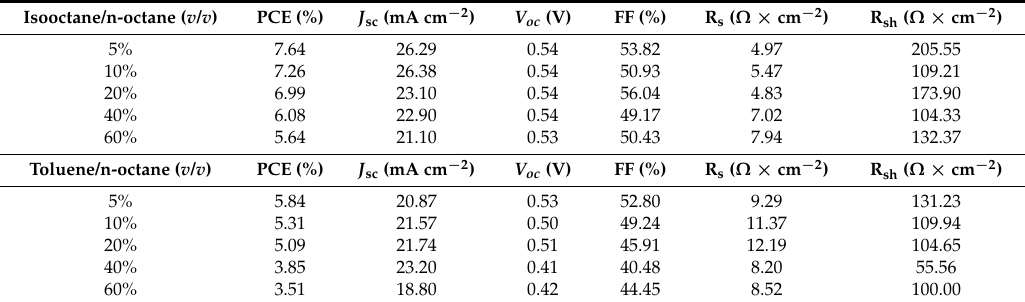
Figure 5. ( a ) J–V characteristic of PbS CQDs solar cells with n-octane/isooctane hybrid solvent and ( b ) the corresponding EQE spectrum; ( c ) J–V characteristic of PbS CQDs solar cells with n-octane/toluene hybrid solvent and ( d ) the corresponding EQE spectrum. Table 3. Photovoltaic parameters obtained from the J – V curves (Figure 5a,c) for solar cells with n-octane/isooctane and n-octane/toluene hybrid solvent.